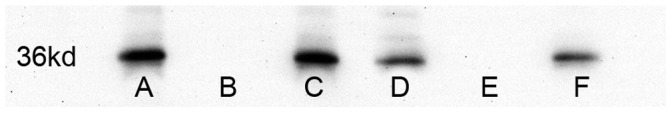
Coimmunoprecipitation of PCNA with HLA I.DB and DU145 cell lysates were first cleared of endogenous and cancerous immunoglobulins, as detailed in material and methods prior to precipitation experiments. Precleared lysates from DB (lanes A–C) and DU145 (lanes D–F) cells were subjected to immunoprecipitation with 3 µg of anti-β-2-microglobulin antibody (lanes A, D) or mouse IgM control of irrelevant specificity (lanes B, E). Precleared cell lysate was used as a positive control (lanes C–F). Reduced samples were resolved on a 10% SDS-PAGE gel and blotted with anti-PCNA antibody.